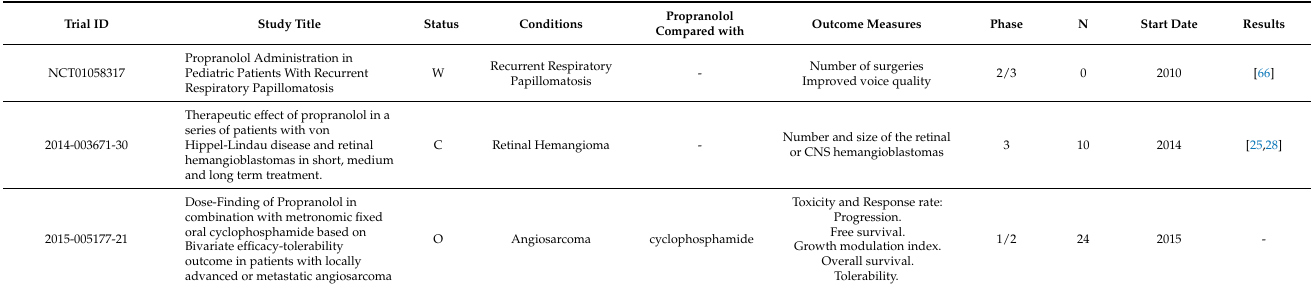
Table 1. Propranolol in single or combined therapy in clinical trials of rare